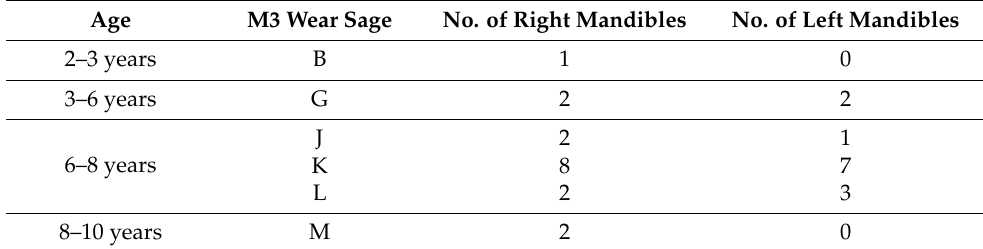
Table 4. M3 wear stage and estimated age of right and left mandibles recovered from the Vilauba pit. Age M3 Wear Sage No. of Right Mandibles No. of Left Mandibles